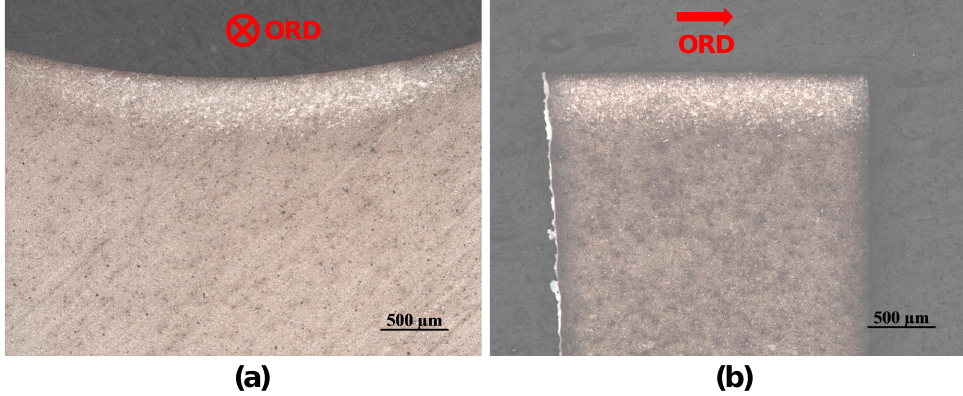
Figure 7. Formation of LERs in M50 bearing steel observed from axial section ( a ) and circumferential section ( b ). The RCF test was conducted with contact pressure of 2.95 GPa at 127 ◦ C for 1.3 × 10 9 cycles. The images were